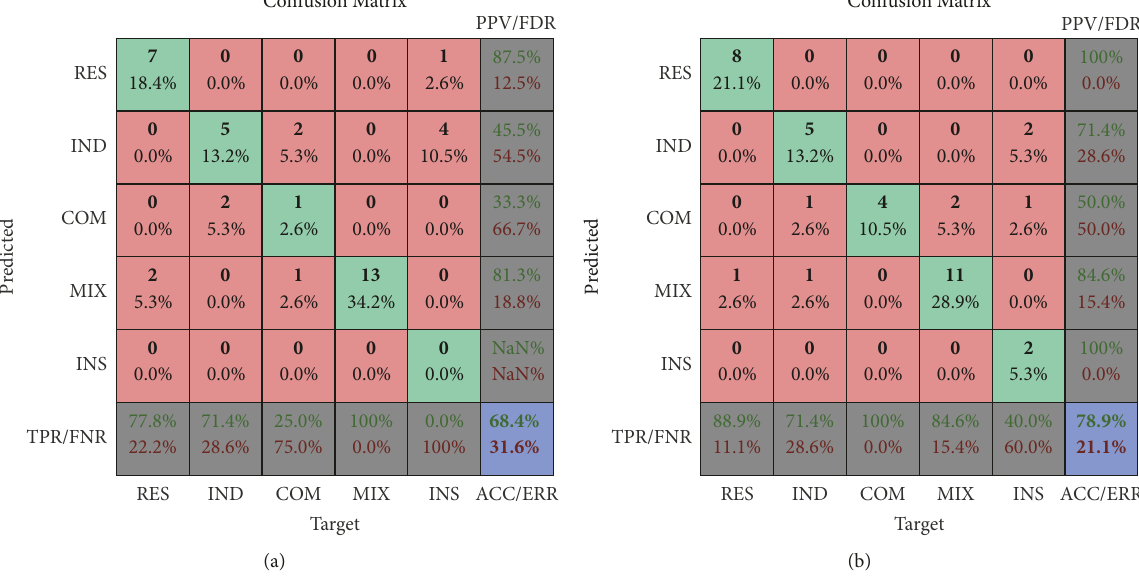
Figure 5: Confusion matrix for KNN classifiers using (a) weekday and (b) weekday-weekend testing